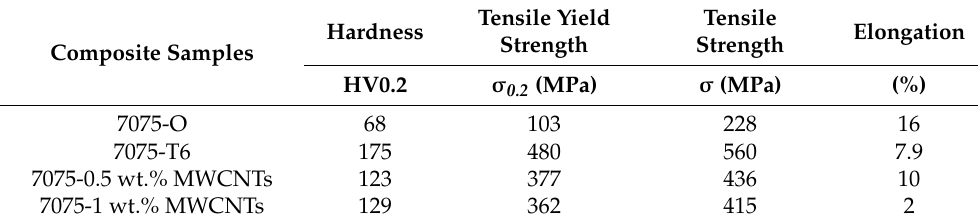
Table 3. Average mechanical properties of 7075- MWCNTs composites.